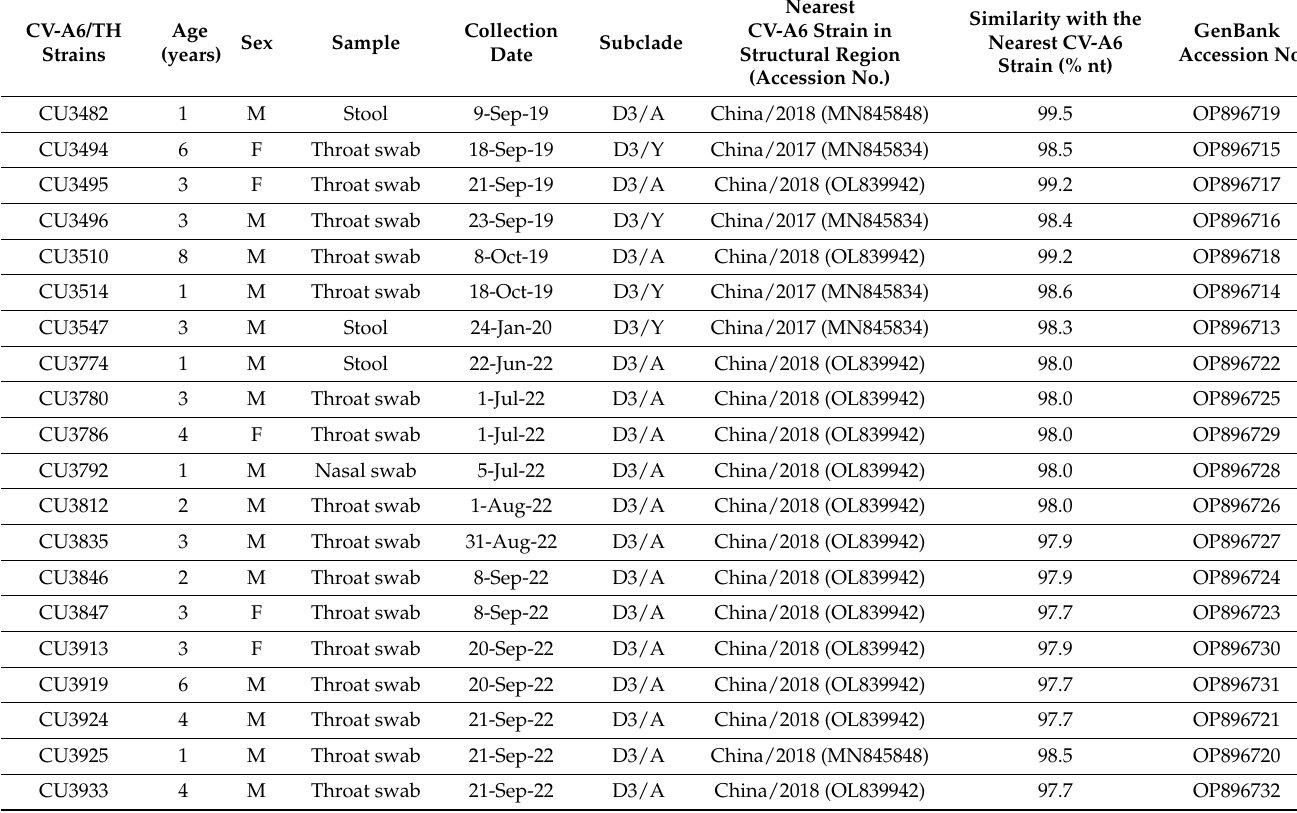
Table 1. Demographic characteristics and characterization of 20 CV-A6/TH strains based on structural